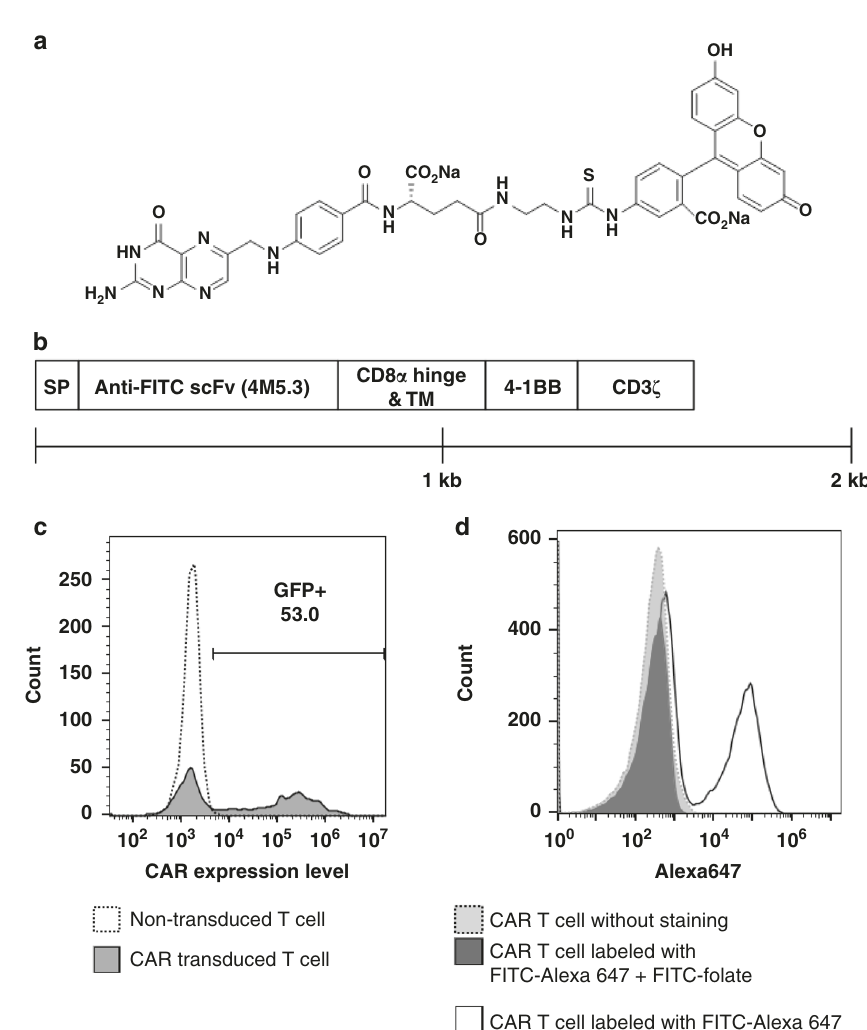
Fig. 1 Design and characterization of an anti- fl uorescein CAR T cell and fl uorescein-folate bispeci fi c adapter. a Structure of fl uorescein-folate (FITC-folate). b Diagram showing the construction of anti- fl uorescein CAR, where SP = signal peptide, scFv = single chain variable fragment that recognizes fl uorescein with a K D = 270 fM, TM = transmembrane domain, 4-1BB = cytoplasmic activation domain from CD137, and CD3 ζ = the cytoplasmic activation domain of CD3 zeta. c Transduction ef fi ciency of CAR T cells evaluated by fl ow cytometry. Open histogram: Non-transduced T cells; fi lled histogram: T cells transduced with lentivirus expressing GFP and the CAR construct shown in ( b ). d Demonstration that FITC-folate binds to anti- fl uorescein CAR T cell. Filled histogram (gray): anti- fl uorescein CAR T cell without staining; open histogram: anti- fl uorescein CAR T cell labeled with FITC-Alexa647 (10 nM); fi lled histogram (black): anti- fl uorescein CAR T cell labeled with FITC-Alexa647 (10 nM) in the presence of competing 100-fold excess FITC-folate (1